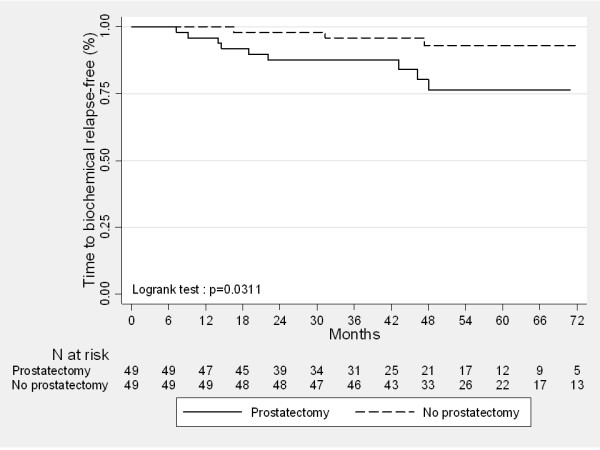
Kaplan Meier curves comparing biochemical relapse-free survival for localized prostate cancer patients treated with exclusive IG-IMRT and radical prostatectomy followed by IMRT calculated from the start of any treatment (p = 0.031, univariate analysis).